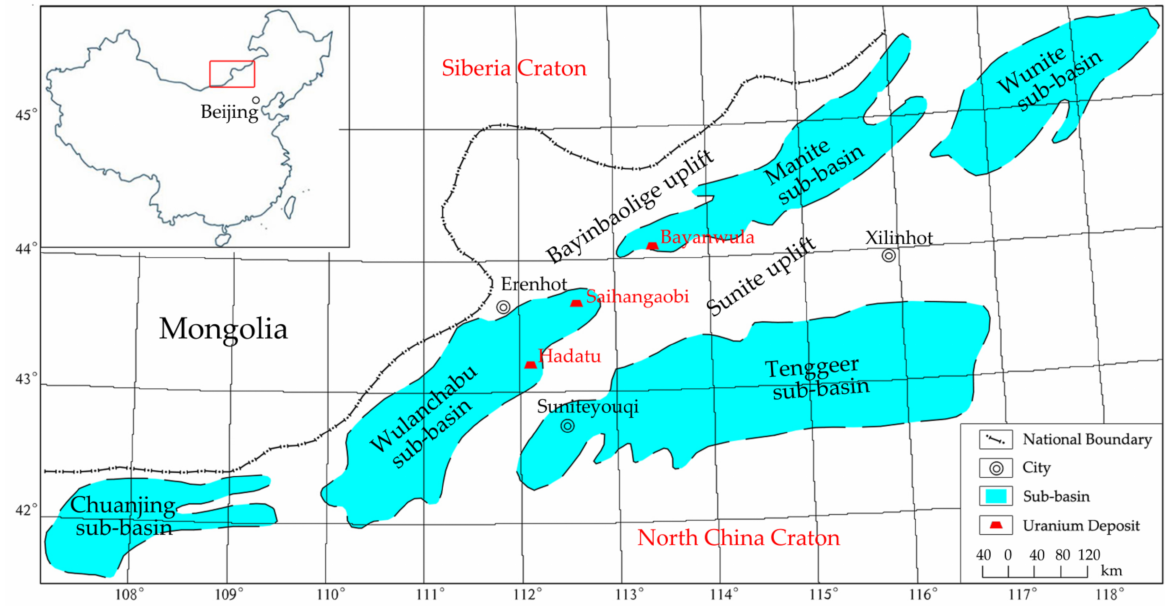
Figure 1. Tectonic units of Erlian basin and the distribution of SUDs (modified from Qiu et al.